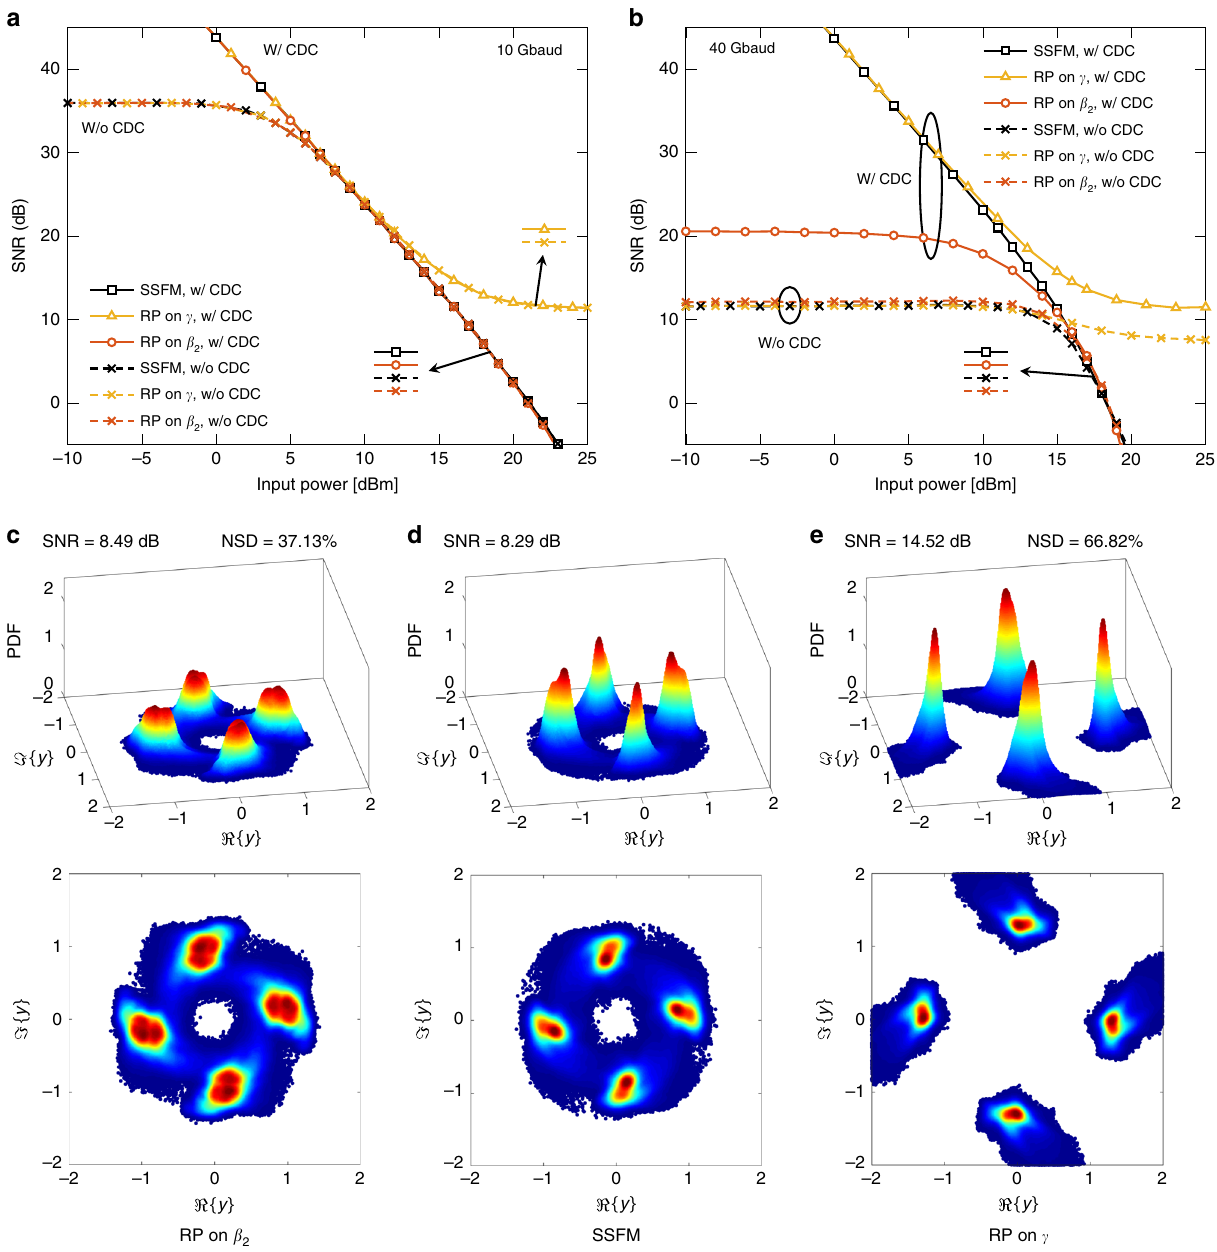
Fig. 9 SNR versus input power, received constellations, and their respective PDFs. On the SNR results, receivers with (w/) and without (w/o) CDC were considered for a QPSK modulation over a 20 km NZDSF. The constellations were obtained for 40 Gbaud with CDC at 16 dBm. a SNR results for the three models at a symbol rate of 10 Gbaud. b SNR results for the three models at 40 Gbaud. c Received RP on β 2 constellation and respective PDF. d Received SSFM constellation and respective PDF. e Received RP on γ constellation and respective PDF. The arrows pointing to the markers in a and b represent which curves are overlapped in those parts of the fi gure. In c , d , and e , the respective SNR values are shown on top of each of them. For c and e , the NSD values are also